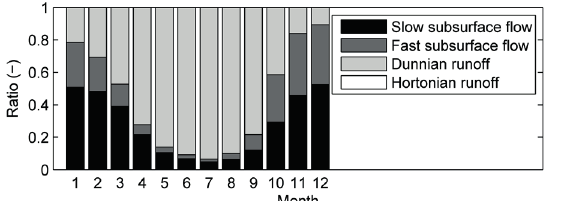
Fig. 4 The monthly ratio of the subsurface flow to the streamflow from THREW model.